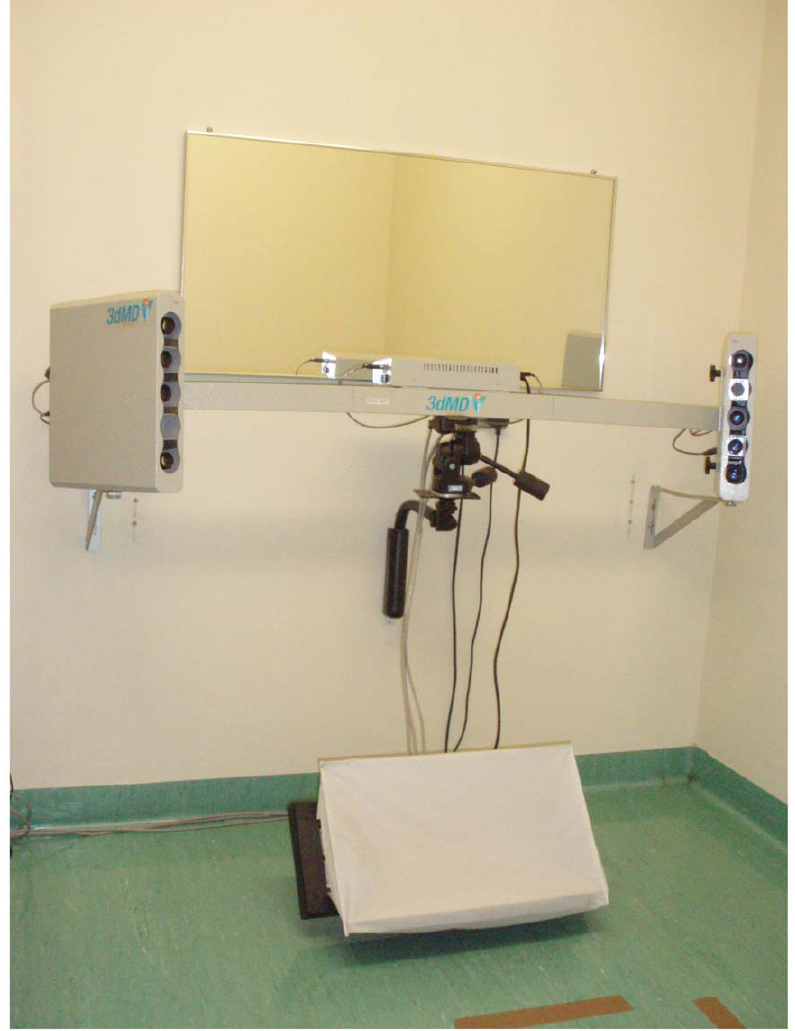
Figure 2. The 3dMDface stereophotograhic system.